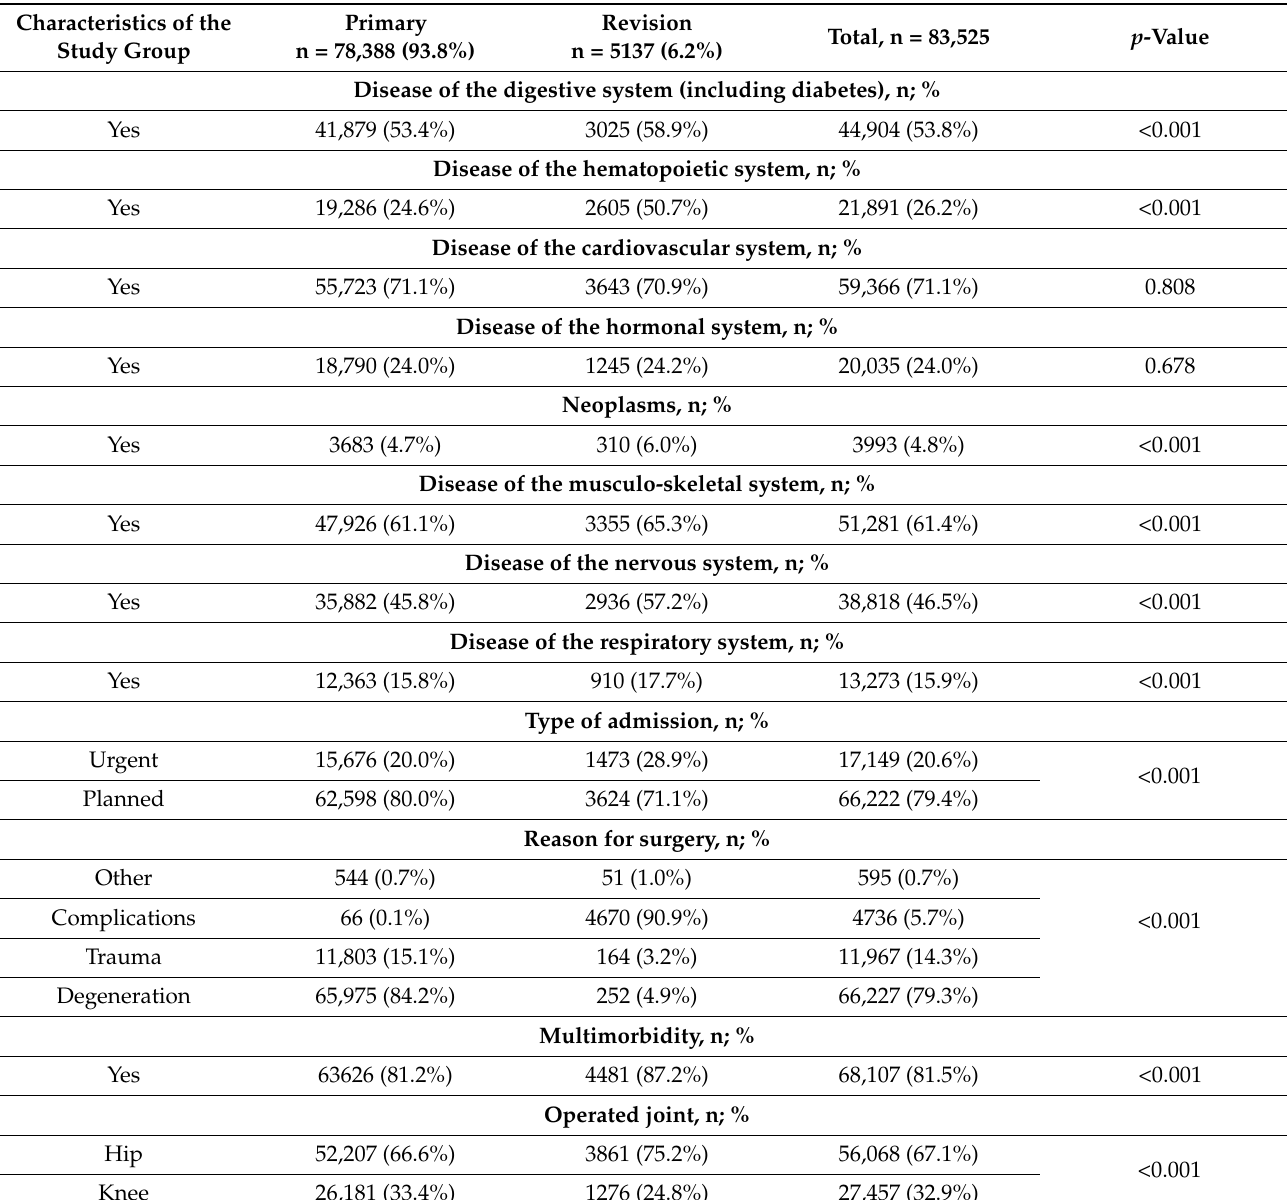
Table 4. The burden of patients divided into the primary and revision